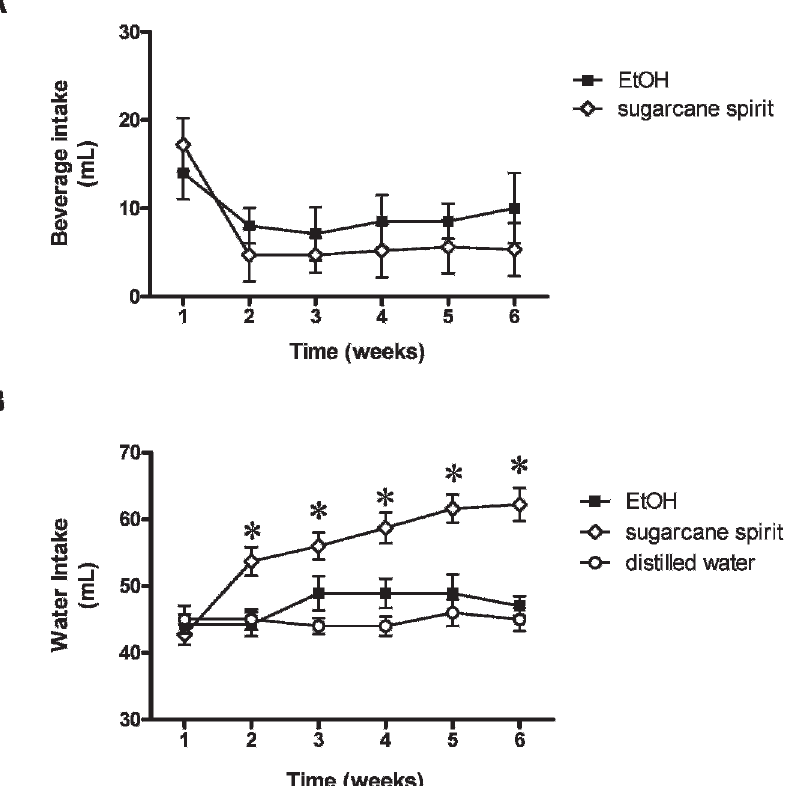
Figure 1 - A . The ethanol and sugarcane spirit consumption during the six-week experimental period. B . Water intake during the six- week experimental period in the three groups. The data are presented as the mean ¡ SEM over the six weeks of sugarcane-spirit or ethanol consumption. * p , 0.05 compared to the ethanol or distilled-water group.